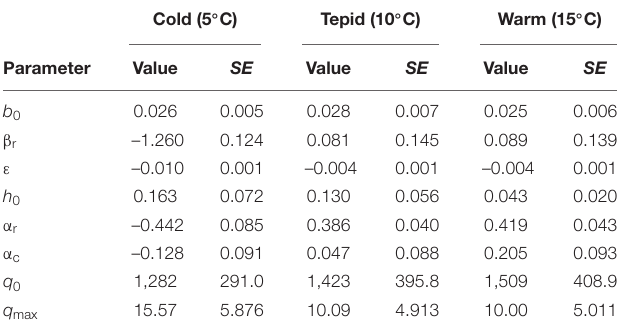
TABLE 1 | Parameter value estimates with associated standard errors (SE) at each experimental temperature for the best-fitting generalized Type-III functional response model (see Equations 2–7 for the model